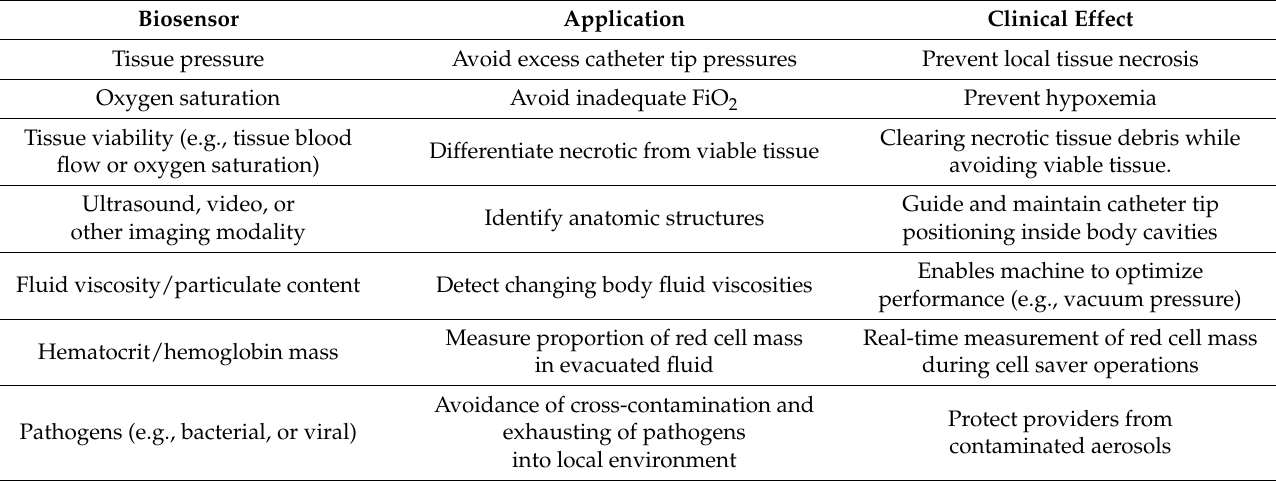
Table 3. Potential sensor applications for portable medical suction